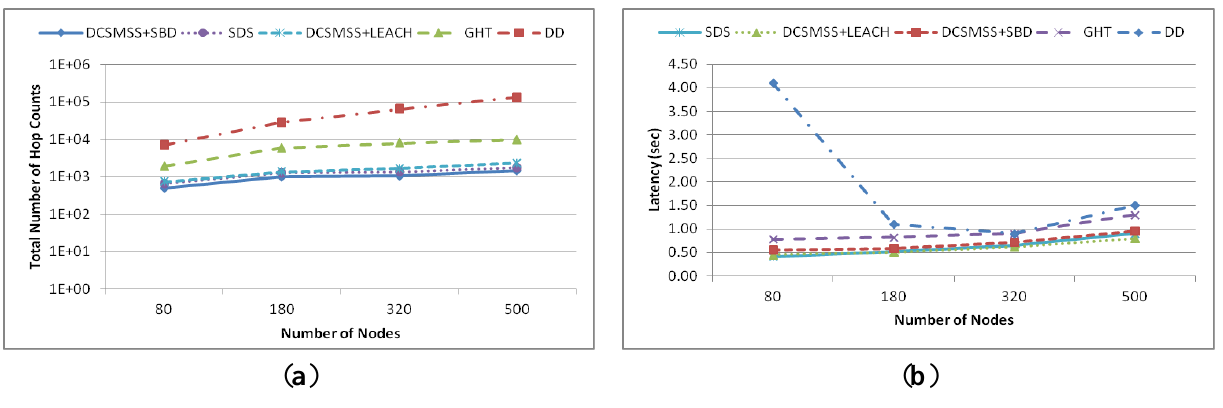
Figure 17. ( a ) Total number of events and ( b ) discovery rate.